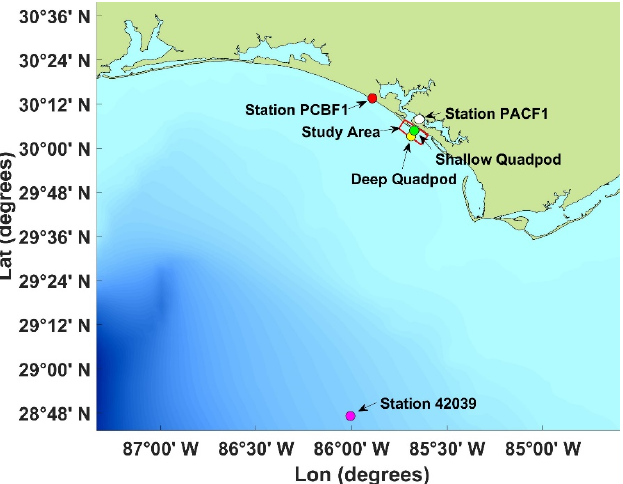
Figure 2. Northern Gulf of Mexico of the coast of Panama City with locations of the shallow quadpod (30°04.81 ′ N, 85°40.41 ′ W), deep quadpod (30°03.02 ′ N, 85°41.34 ′ W), and the NOAA buoy stations PACF1, PCBF1, and 42039. The study area is enclosed by the red lines. The NOAA buoy station PACF1 is nearest to the study area.